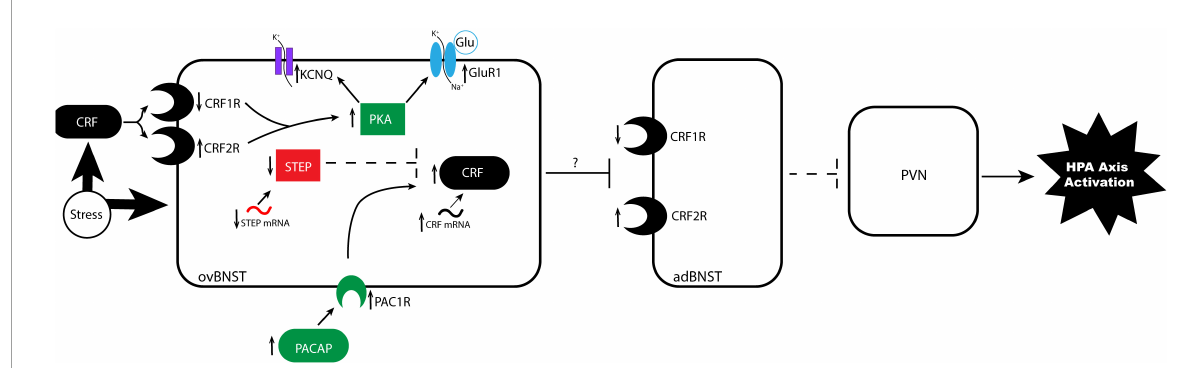
FIGURE2 Proposed mechanism of stress-induced neuroplasticity in the anterodorsolateral BNST. In the stressed brain, alterations to CRF G-protein coupled receptors alter sensitivity to CRF binding in undetermined ways. BNST CRFR1 expression is reduced and CRFR2 expression is increased, resulting in altered sensitivity to CRF binding from external projections, such as the CeA. Binding triggers a signaling cascade resulting in increased PKA, which promotes phosphorylation of glutamate receptor GluR1 and phosphorylation of the KCNQ channel. These parallel phosphorylation pathways increase excitability in the ovBNST by increasing mEPSCs and resting membrane potential, respectively. A second pathway regulates CRF signaling, wherein stress increases CRF mRNA, increases upstream regulator PACAP and its receptor PAC1, and decreases upstream inhibitor STEP mRNA and protein production. Increased excitability in ovBNST likely increases GABAergic inhibition of anterodorsal BNST subnuclei that project to the hypothalamus, disinhibiting the PVN. The PVN then releases increased levels of CRF to the anterior pituitary, which activates the stress response in the body. adBNST, anterodorsal BNST; CRF, corticotropin-releasing factor; CRFR1, CRF receptor 1; CRFR2, CRF receptor 2; GluR1, glutamate receptor 1; ovBNST, oval nucleus of the BNST; PACAP, pituitary adenylate cyclase activating polypeptide; PAC1, PACAP receptor 1; PKA, protein kinase A; PVN, paraventricular nucleus of the hypothalamus; STEP, striatal-enriched protein tyrosine